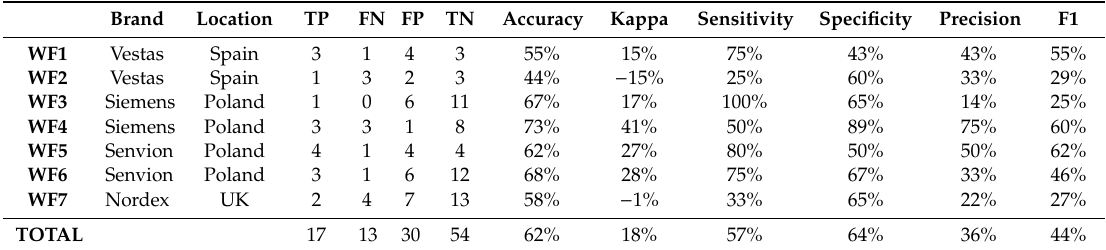
Table 4. Results obtained using the autoencoder. WF stands for Windfarm, TP True Positive, FN False Negative, FP False Positive and TN True Negative.